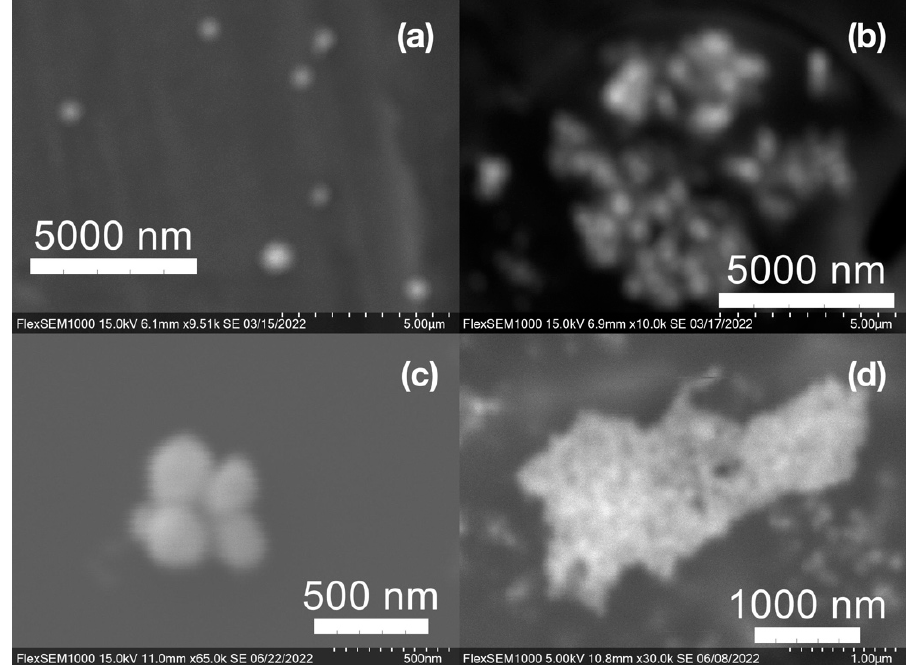
Figure 9. Silver (Ag) nanoparticles synthesized with ( a ) medium roast coffee grounds (SCGs) from French press brew (SMH); ( b,c ) medium roast SCGs from cold brew (SMC); and ( d ) dark roast SCGs from espresso brew (SDE).